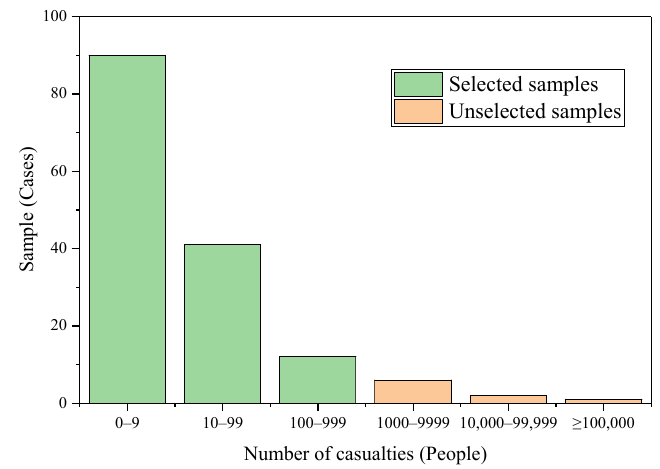
Figure 3. Piecewise frequency statistics of earthquake casualties.